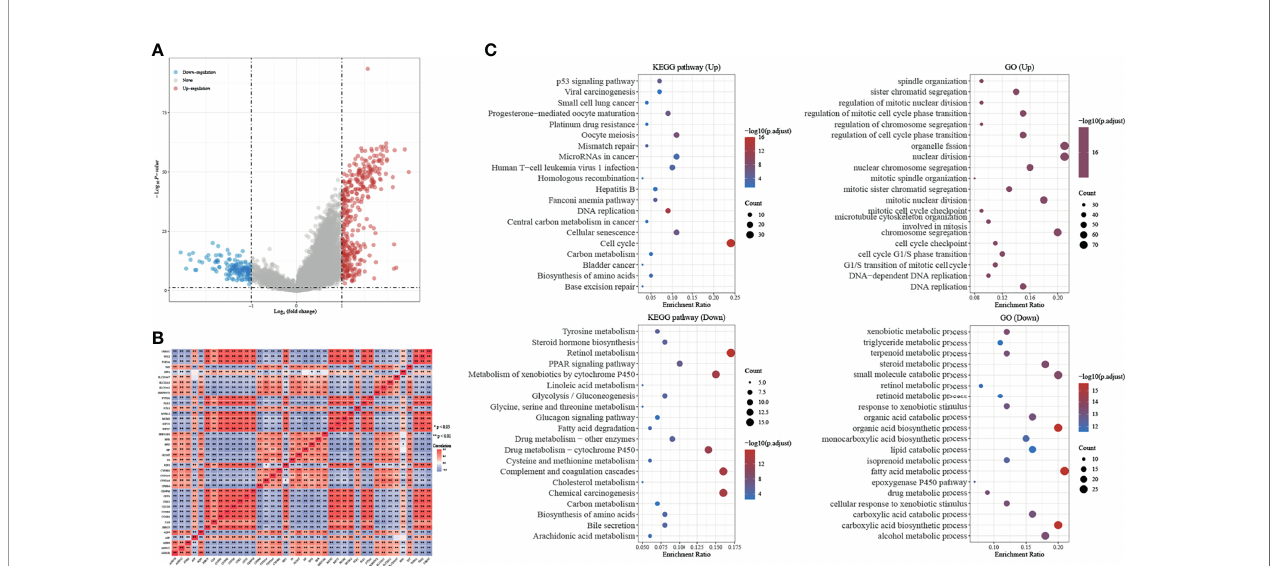
FIGURE 5 | Identi fi cation and GSEA analysis of DEGs in H2AFZ high and H2AFZ low group. (A) Volcano plot showing DEGs in H2AFZ high and H2AFZ low group (|log2FC| > 2, p < 0.05) in TCGA-LIHC cohort. p -values were adjusted. (B) Spearman correlation analysis of top 20 upregulated genes and top 20 downregulated genes. (C) Signi fi cantly enriched GO annotations and KEGG pathways of